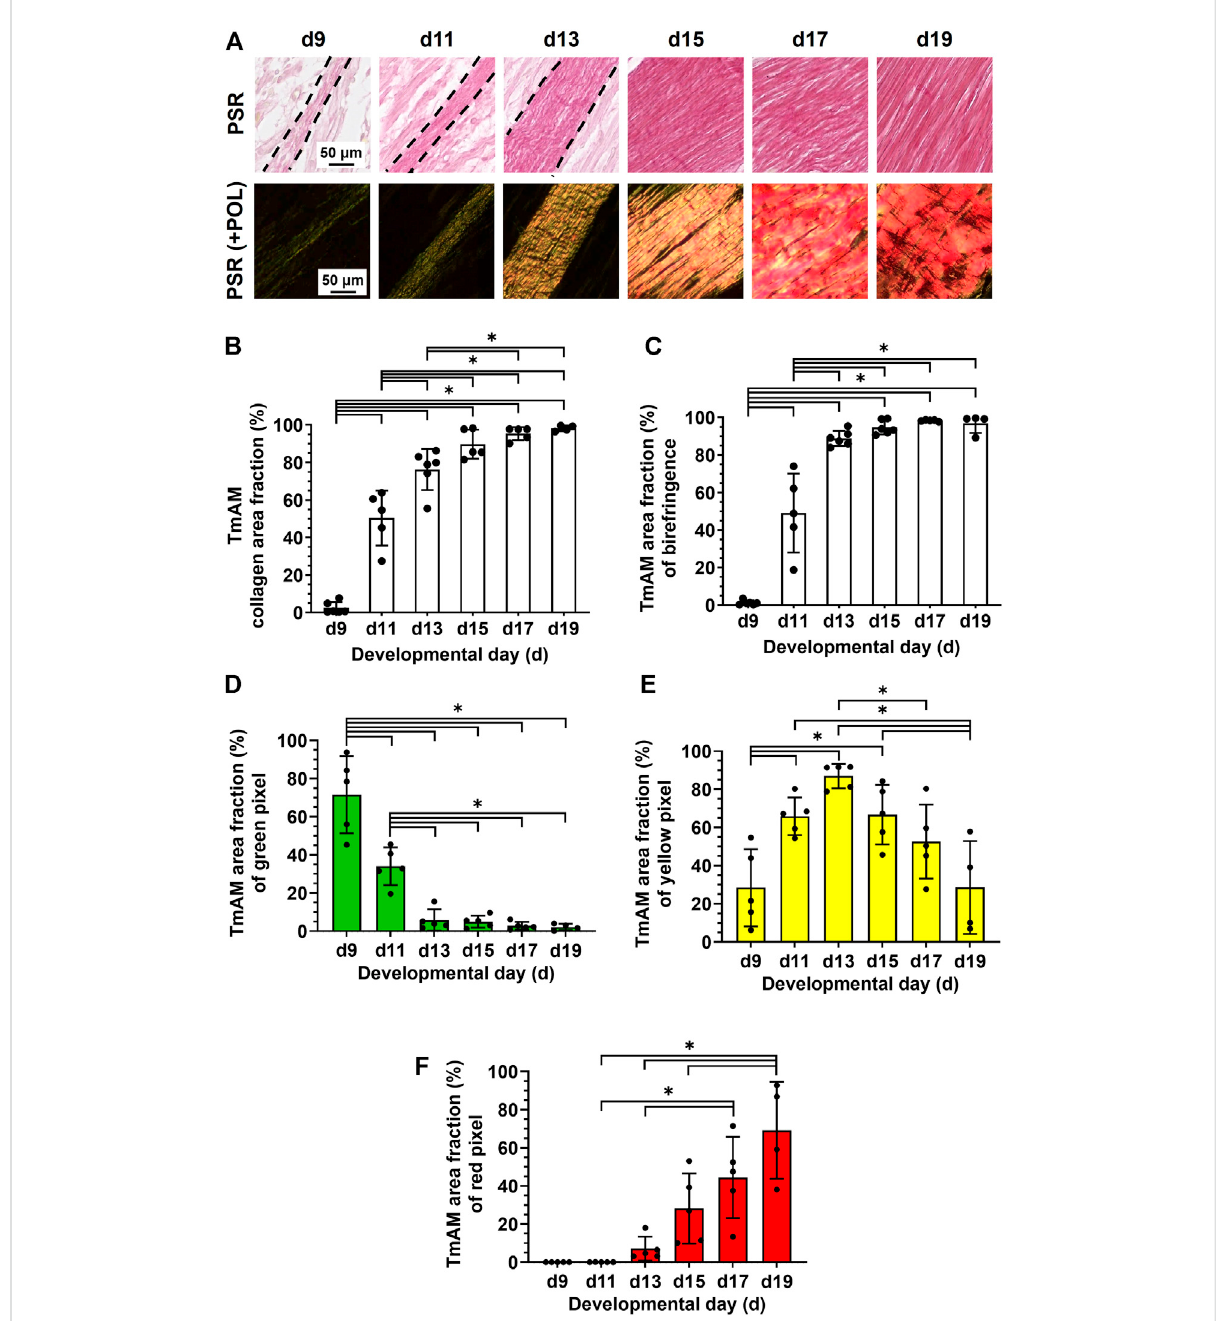
FIGURE 4 Collagen content increased, collagen became more aligned, and fi ber maturity increased in jaw-closing TmAM between d9 and d19. (A) Representative bright fi eldandpolarization(POL)imagesofPSR-stainedTmAM. (B) Collagencontent increasedsigni fi cantly overtimeandplateaued after d13 in TmAM. (C) In the TmAM, collagen birefringence signal increased signi fi cantly over time and reached a plateau after d13. (D – F) Collagen fi bers progressed from mainly immature (D) during early stages, to intermediate (E) , and fi nally to mature (F) during late stages of development in